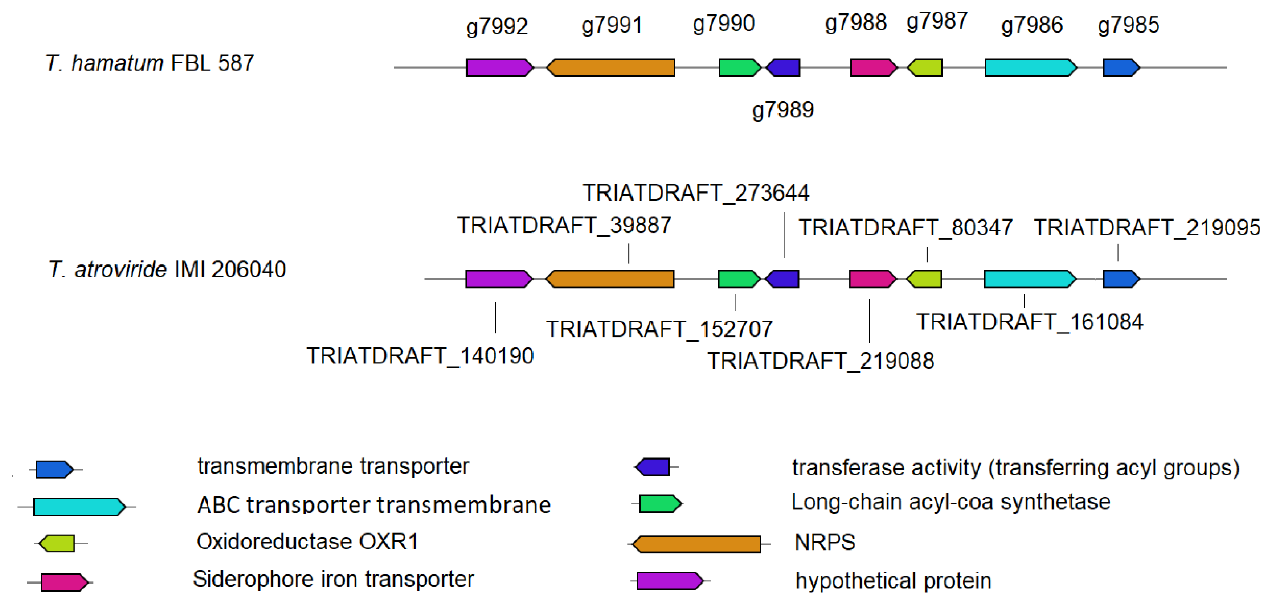
Figure 3. The putative extracellular siderophore dimethylcoprogen gene cluster identified using the tool antiSMASH, version 6.0.0 (see [29]) in the genome of T. hamatum FBL 587. For clarity, only the orthologue gene cluster from T. atroviride IMI 206040 (representative Trichoderma high-quality genome in the antiSMASH database; https://antismashdb.secondarymetabolites.org, accessed on 1 June 2021; [30]) was used for comparison. In T. hamatum FBL 587, the candidate BGC genes were assembled to a putative dimethylcoprogen BGC (node_221_length_57612_cov_30.100447, 29,375 nt, start: 28237, end: 57612). The sequence analysis revealed the presence of eight open reading frames, g7985 – g7992 , of which at least 5 genes are highly likely to be involved in dimethylcoprogen biosynthesis. The gene g7985 encodes a putative transmembrane transporter, g7986 encodes for a homologue to ABC transmembrane transporter, g7987 encodes for a homologue to oxidoreductase, g7988 encodes for a homologue to the siderophore iron transporter, g7989 encodes for a homologue to acetyltransferase activity, g7990 encodes for a homologue to long-chain acyl-CoA synthetase, g7991 encodes for a NRPS protein, and g7992 encodes for a hypothetical protein of unknown function. Sequence comparison using BLASTN analysis indicated that the NRPS cluster of T. atroviride IMI 206040, locus: NW_014013633, 430,88 bp, start: 76225, end: 119313, showed substantial similarity (identity at nucleotide level of 86.35%, cover: 87%) in relation to that of T. hamatum FBL 587. The NRPS cluster of T. atroviride IMI 206040 putatively consisted of eight genes. The gene locus_tag TRIATDRAFT_219095 encodes for a protein with predicted transmembrane domains; the gene locus_tag TRIATDRAFT_161084 encodes for predicted MDR-type topology of transmembrane domains and nucleotide-binding folds (TMD6-NBF)2; the gene locus_tag TRIATDRAFT_80347 encodes for a hypothetical protein; the gene locus_tag TRIATDRAFT_219088 encodes for hypothetical protein with transmembrane domains; the gene locus_tag TRIATDRAFT_273644 encodes for a putative siderophore biosynthesis protein; the gene locus_tag TRIATDRAFT_152707 encodes for a NRPS-like protein, AMP-dependent synthetase and ligase; the gene locus_tag TRIATDRAFT_39887 encodes for a NRPS related to NPS6 (siderophore) of Cochliobolus heterostrophus ; the gene locus_tag TRIATDRAFT_140190 encodes for a hypothetical protein. Gene clustering is represented by the arrows superposed on the horizontal black line. Intergenic spaces are not drawn in scale.